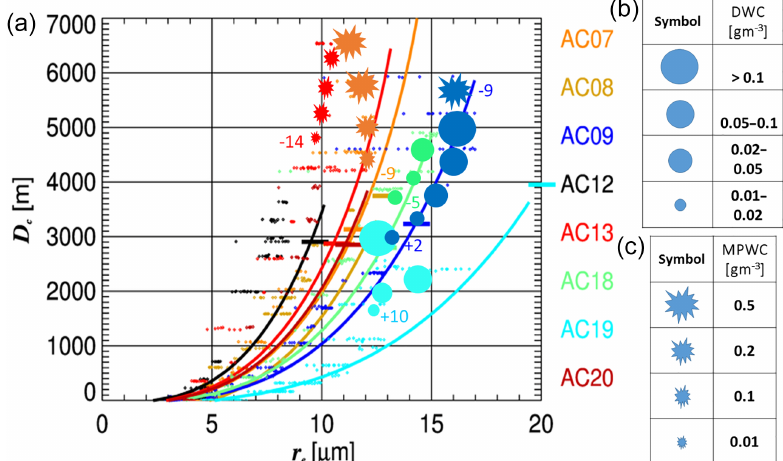
Figure 16. CDP-measured cloud droplet effective radius ( r e ) (colored dots) and estimated cloud droplet adiabatic effective radius ( r ea ) (colored lines) as a function of cloud depth ( D c ) for all flights (indicated by colors). The height of 0 ◦ C is indicated by a horizontal bar across the r ea line. The circles indicate the approximate values of drizzle water content (DWC) calculated from the CCP–CIP data; the range of DWC values is indicated in the table in panel (b) . The star symbols indicate the approximate mixed-phase drizzle water content (MPWC) values calculated from the CCP–CIP data (indicated in the table in panel c ). The temperature in ◦ C of rain or ice initiation ( D r and D i , respectively) is indicated by colored numbers close to the circle or star symbols.